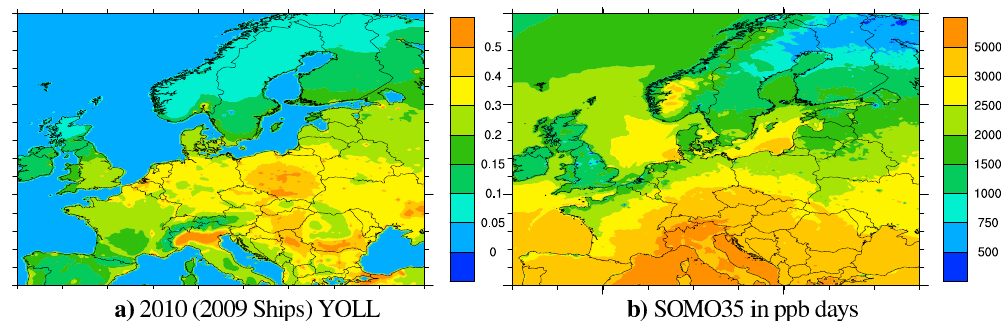
Figure 3. Years of life lost (YOLLs) per person (a) and SOMO35 (b) as calculated from the reference model